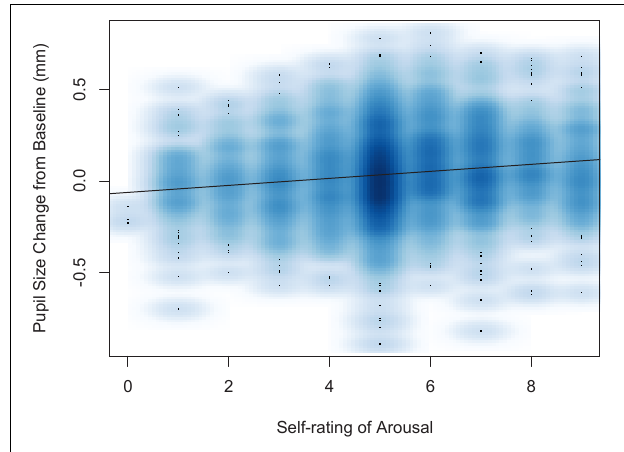
FIGURE 2 | Smoothed scatterplot showing the relationship between participants’ self-ratings of arousal and their change in pupil size from baseline on each trial. The regression indicates a significant relation between the two